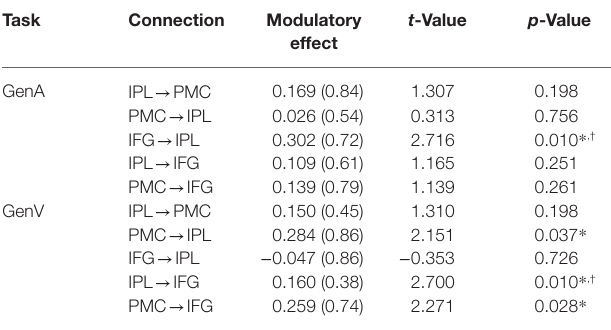
TABLE 4 | Results of one-sample t -test for modulatory effects for the winning model (No. 55). Task Connection